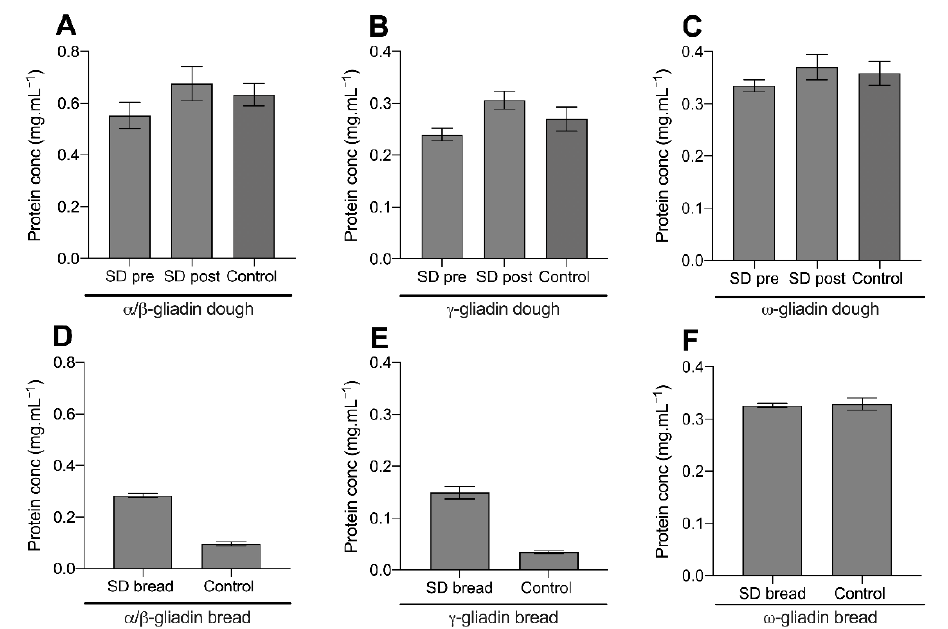
Figure 1. Extractable gliadin protein concentrations from sourdough and fast fermentation control products determined using HPLC. Gliadin proteins were extracted from sourdough before (pre) and after (post) dough fermentation and from the sourdough bread. Gliadin proteins were extracted from the fast fermentation control dough and bread. The concentration of extractible ( A ) α / β -gliadin from doughs, ( B ) γ -gliadin from doughs, ( C ) ω -gliadin from doughs, ( D ) α / β -gliadin from bread, ( E ) γ -gliadin from bread, and ( F ) ω -gliadin from bread. Samples were analysed in duplicate. Error bars display the standard deviation of the mean.